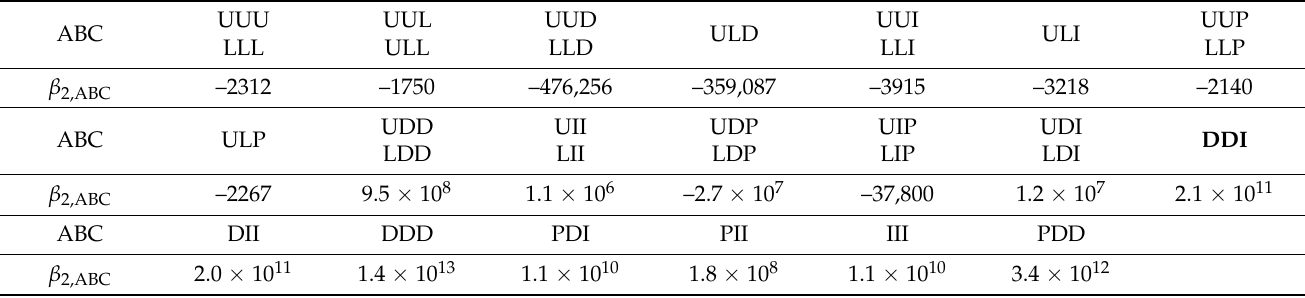
Table 2. Values of integrals β 2,ABC for different types of interacting particles. The values are in the units of nm 4